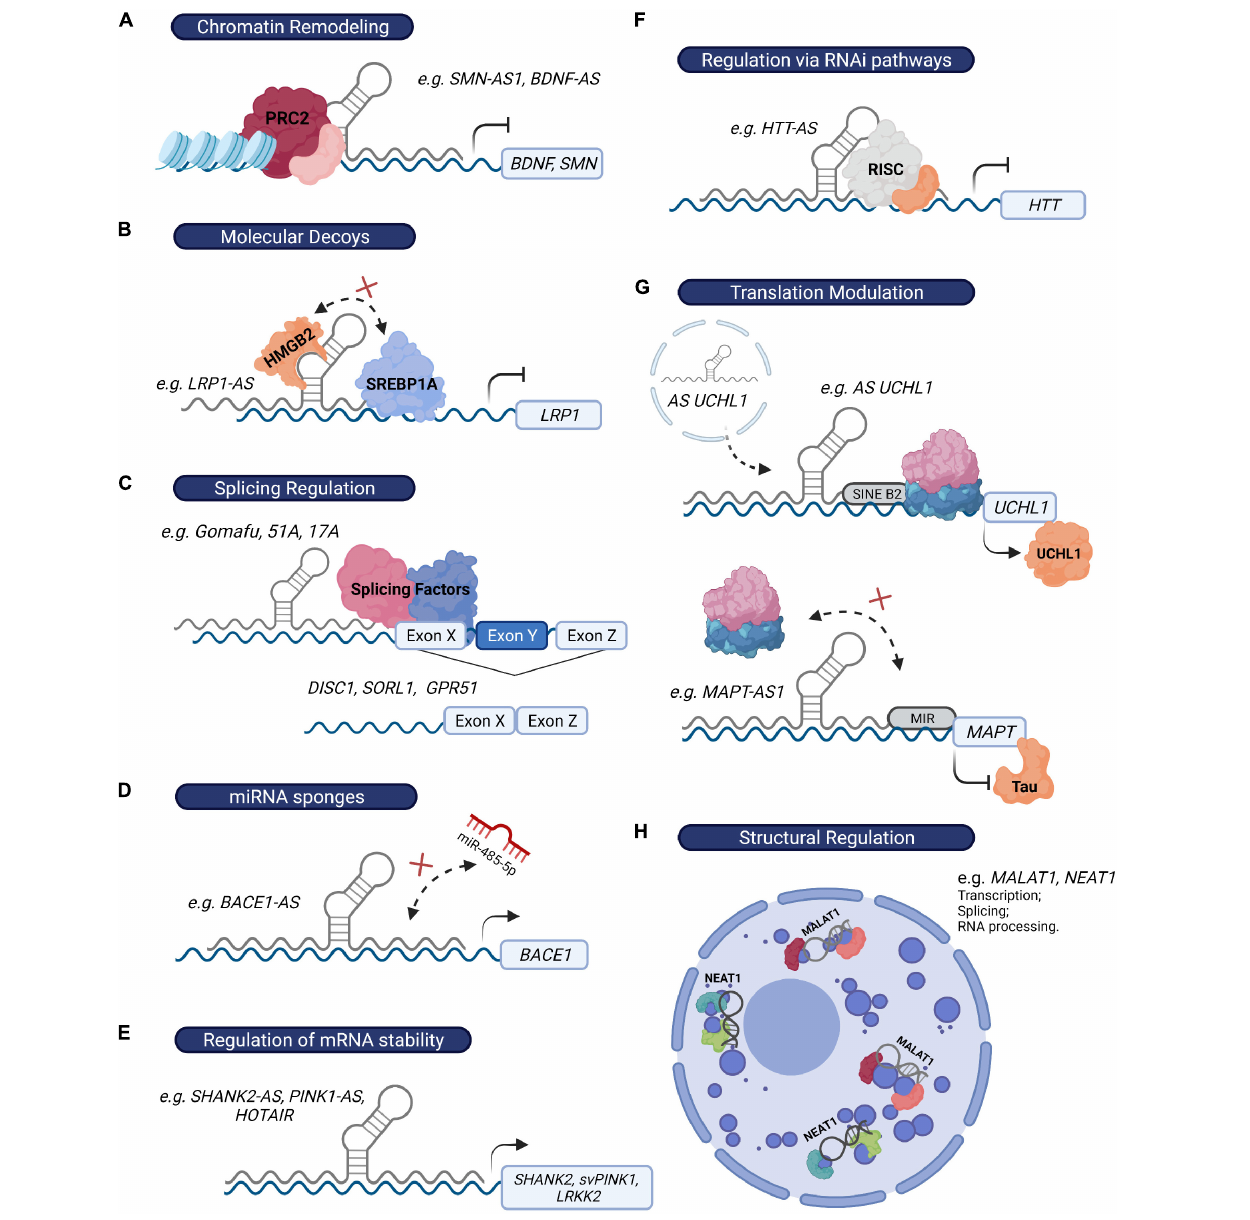
FIGURE 3 | LncRNAs regulate gene expression through multiple mechanisms. (A) LncRNAs can recruit chromatin modifiers (e.g., PRC2 complex) to their target-gene promoters and epigenetically influence their expression (e.g., BDNF-AS and SMN-AS1 ). (B) Alternatively, they can modulate transcription by acting as molecular decoys and sequester specific chromatin and non-chromatin modulators, transcription factors, or other regulatory proteins from the promoters of their target genes (e.g., LRP1-AS ). (C) LncRNAs can also influence transcription by affecting the alternative splicing of their target genes (e.g., Gomafu, 51A, 17A ). (D) Some lncRNAs regulate mRNA turnover by acting as miRNA “sponges” (e.g., BACE1-AS ), as they prevent miRNAs from binding their target genes. (E) Additionally, they can directly bind to their target mRNAs, leading to the formation of an RNA-RNA duplex and therefore influencing mRNA stability ( SHANK2-AS , PINK1-AS , and HOTAIR ). (F) LncRNAs can also exert their function via recruitment of the RISC complex to their target mRNA (e.g., HTT-AS ). (G) Some lncRNAs directly modulate translation efficiency of their target genes through the presence of specific sequences that either promote (e.g., SINE B2 element in AS UCHL1 ) or prevent (e.g., MIR sequence in MAPT-AS1 ) the association of ribosome machinery with their target mRNAs. (H) Finally, NEAT1 and MALAT1 exert a crucial structural function in the formation of paraspeckles and speckles, respectively, two nuclear structures that regulate multiple mechanisms, including RNA transcription, splicing and